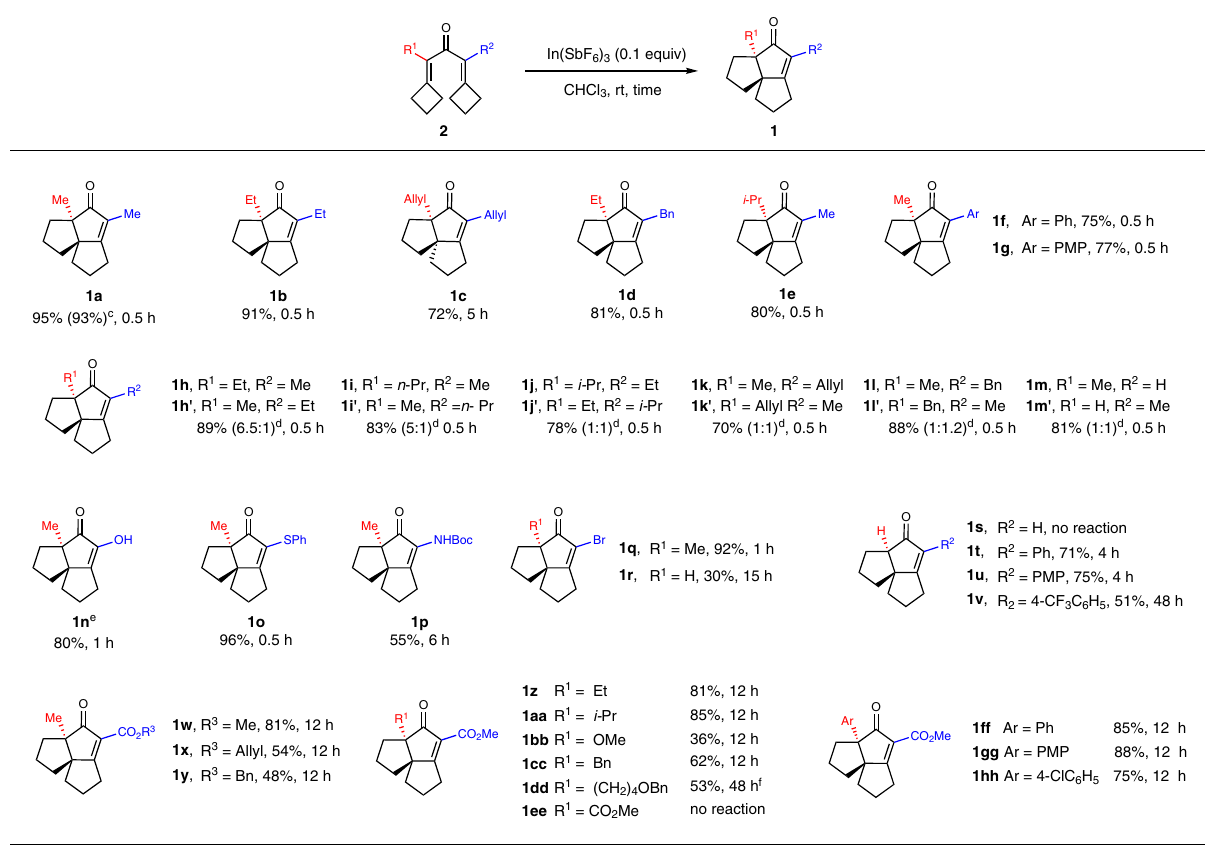
Fig. 2 Substrate expansion by varying substitution (R 1 and R 2 ) at 4 π e-system (a, b, g). ( a ) Reactions were carried out at rt with 0.1 mmol of substrate in 1.0 mL CHCl 3 . ( b ) Isolated yields. ( c ) Reaction with 0.05 equiv In(SbF). ( d ) The ratio determined by 1 H-NMR. ( e ) 2n:R 1 = Me, R 2 = OMe. ( f ) Reaction at 50 °C. ( g ) Unless noted, dr >